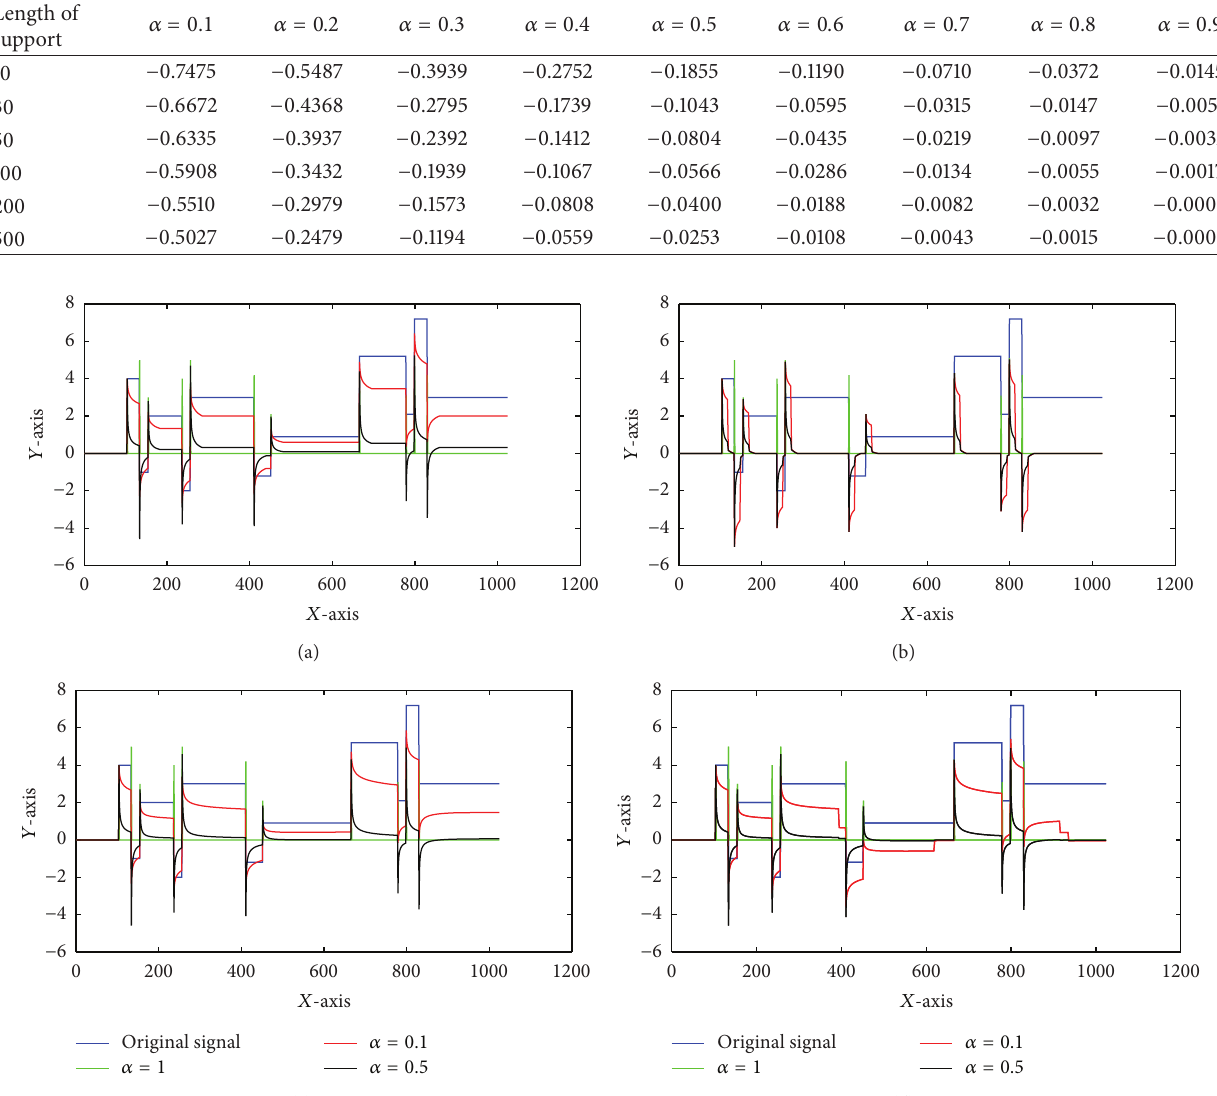
Table 1: Truncated errors of truncated left-handed G-L formula for 𝑠(𝑥) = 1 with support lengths from 10 to 500 ( rows ) and fractional-orders 𝛼 from 0.1 to 0.9 ( columns ) .